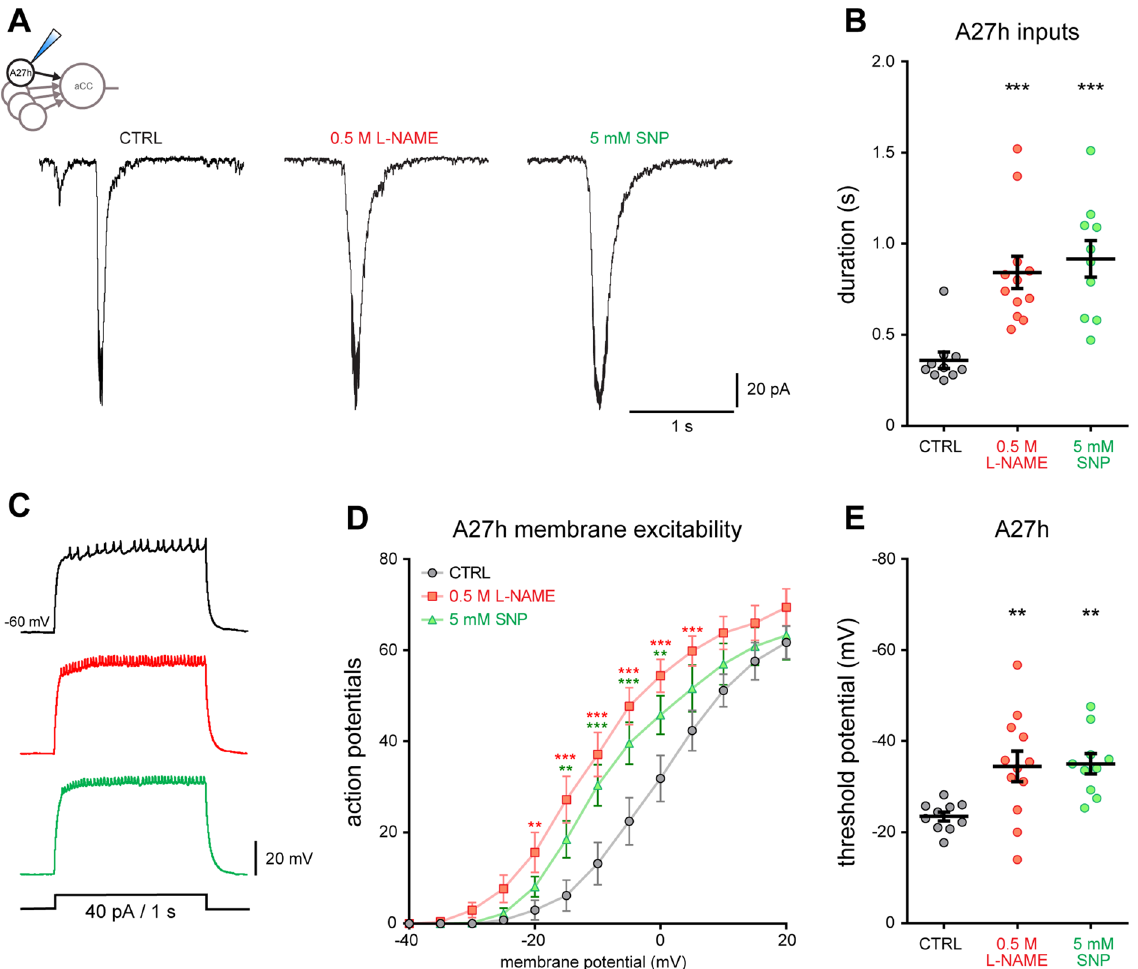
Figure 4. Manipulation of NOS modulates synaptic drive and excitability of the premotor interneuron A27h. ( A ) Voltage-clamp recordings of synaptic currents from the premotor interneuron A27h at L3 following NOS manipulation. Early administration of both 0.5 M L-NAME ( n = 12) or 5 mM SNP ( n = 10) increased duration of A27h synaptic currents ( n = 10). ( B ) Quantification of the duration of A27h synaptic inputs. One-way ANOVA (F (2, 29) = 12.72, p < 0.001) followed by Bonferroni’s post-hoc test. ( C ) Representative traces showing the effect of NOS manipulation on AP firing recorded from A27h and elicited by a depolarizing current injection (40 pA/1 s). ( D ) Changes in membrane excitability of L3 A27h interneurons were determined by injection of successively greater depolarizing current pulses (Δ + 4 pA steps/1 s). A two-way ANOVA revealed a significant effect of voltage (F (13, 377) = 197.1, p < 0.001), NOS manipulation (F (2,29) = 7.005, p = 0.003), and interaction (F (26, 377) = 5.626, p < 0.001). Data are represented as mean ± SEM. ** p < 0.01 and *** p < 0.001, Bonferroni’s post- hoc test, n = 10 in CTRL and 5 mM SNP, n = 12 in 0.5 M L-NAME. ( E ) NOS manipulation shifted the threshold potential in A27h interneurons toward more negative values. One-way ANOVA (F (2, 29) = 6.306, p = 0.0053) followed by Bonferroni’s post-hoc